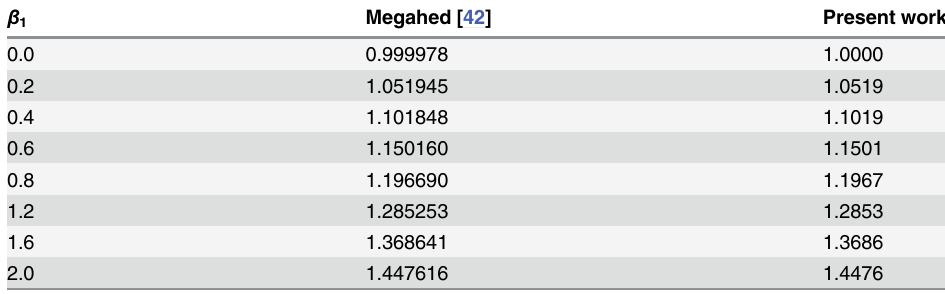
Table 4. Comparative values of – f @ (0) for various values of β 1 when β 2 = λ = N =